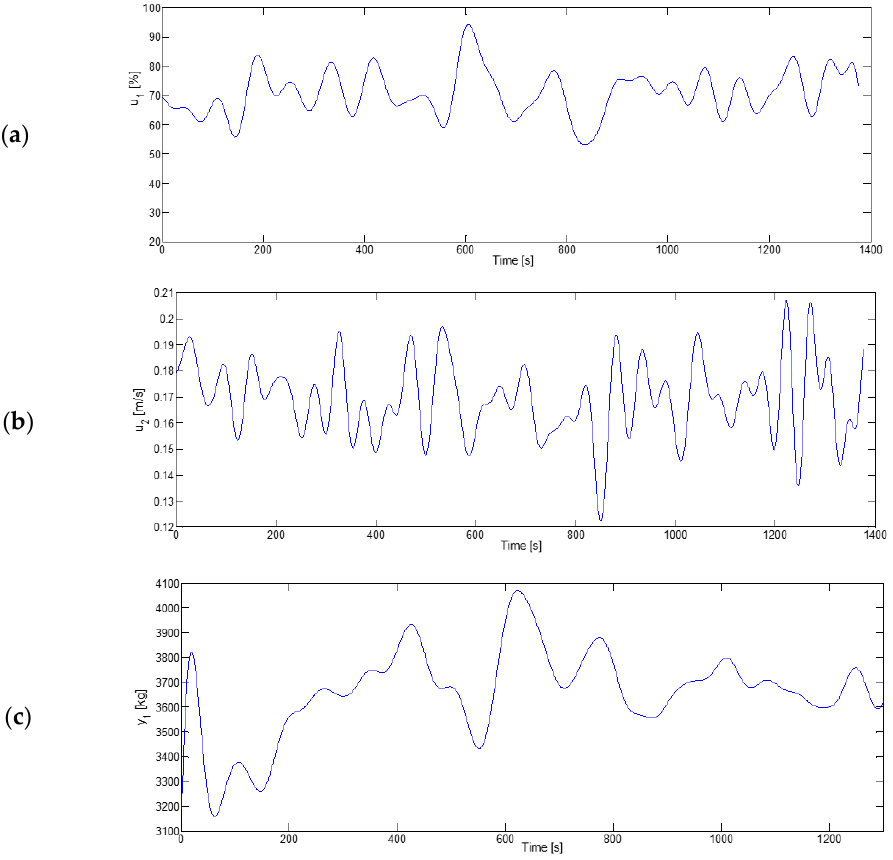
Figure 4. Input/output waveforms used for the identification process: ( a ) Opening degree of discharge slots. ( b ) Bucket conveyor speed graph. ( c ) Weight of material on the conveyor. The Pearson linear correlation coefficient of input and output variables u and y (t) are summarized in Table 1. 1 Table 1. Correlation coefficients of variables u Parameter